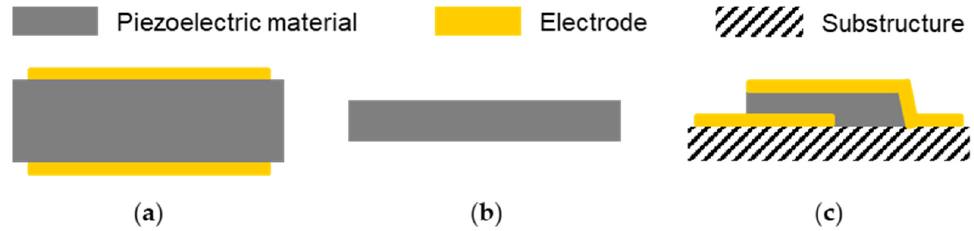
Figure 1. Schematics of bulk acoustic wave devices: ( a ) quartz crystal microbalance (QCM); ( b ) electromagnetic piezoelectric sensor (EMPAS); ( c ) film bulk acoustic resonator (FBAR). Common QCM frequencies are in the range of 5 to 50 MHz. Higher device frequen- cies would be desirable since this would promise higher sensitivities to mass loading.